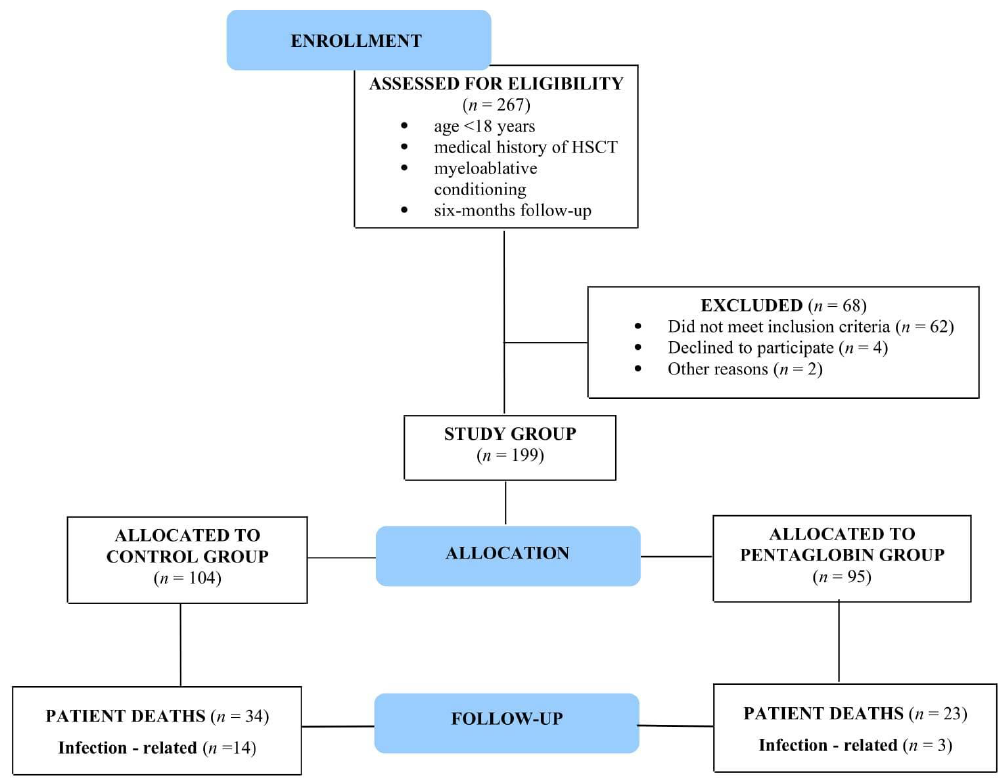
Figure 1. The flowchart shows the number of hematopoietic stem cell transplantation (HSCT) recipients who were screened, enrolled, and included in the final analyses.